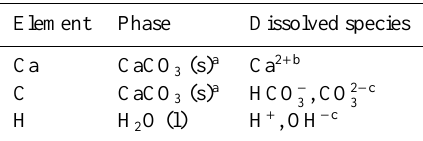
Table 3. Chemical elements, phases and dissolved species in Stan- dard Methods 2330